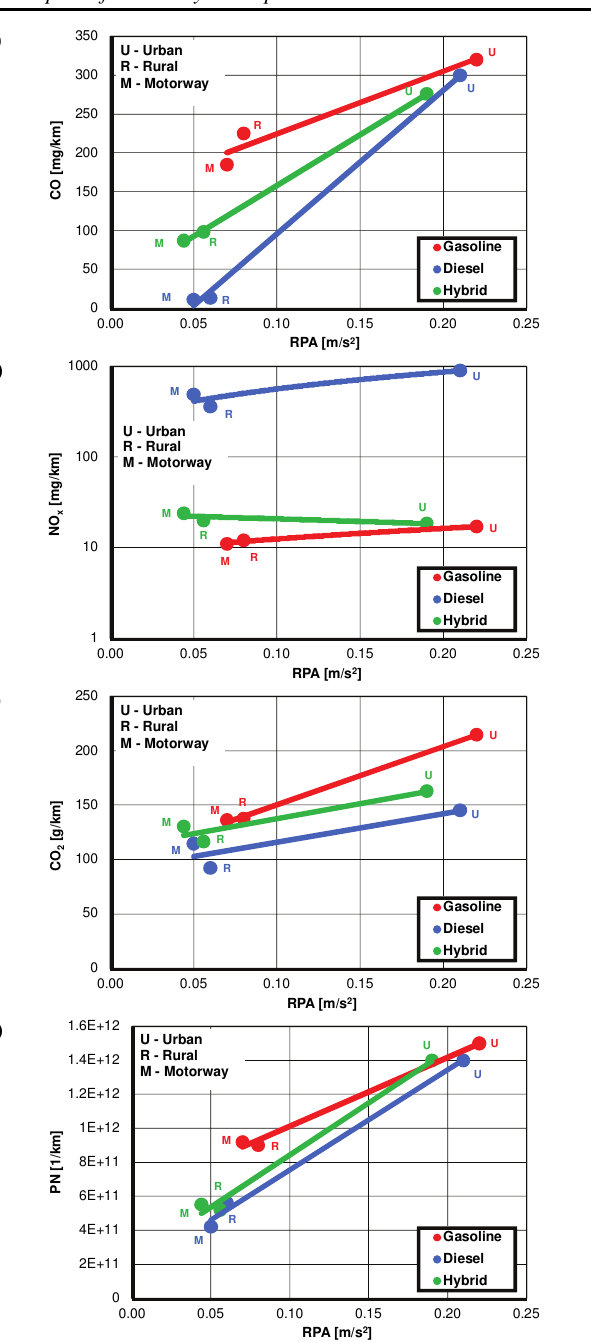
Fig. 15. Correlations between exhaust emissions and relative positive acceleration in particular stages of the test: a) carbon monoxide, b) nitrogen oxides, c) carbon dioxide, d) particle number